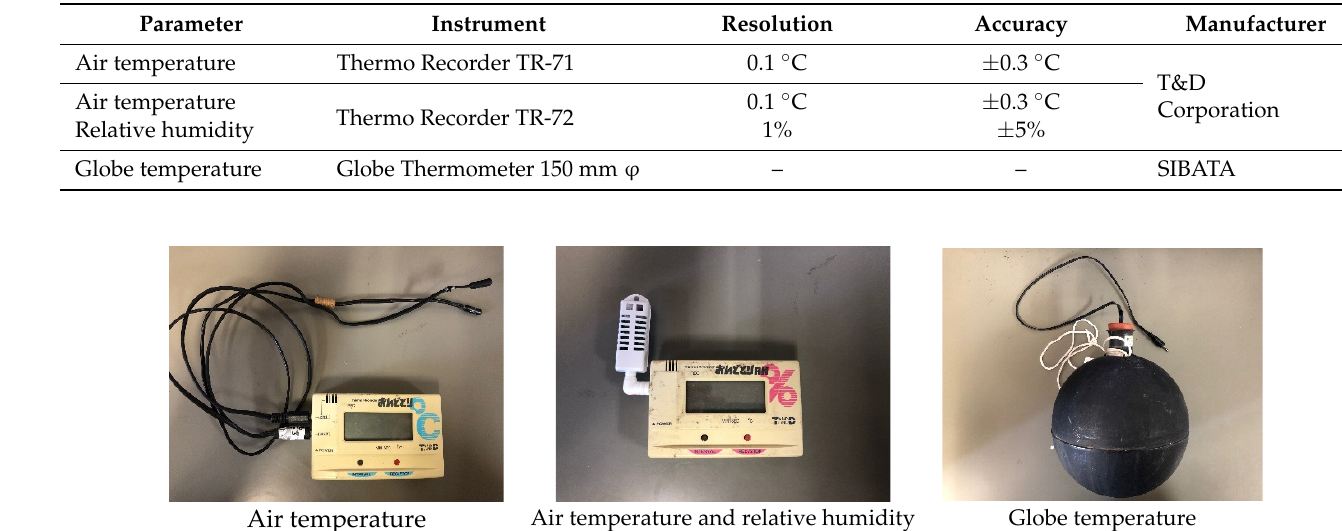
Figure 1. Trends in outdoor temperatures during the study period (August 2010). Table 1. Overview of measurement equipment.